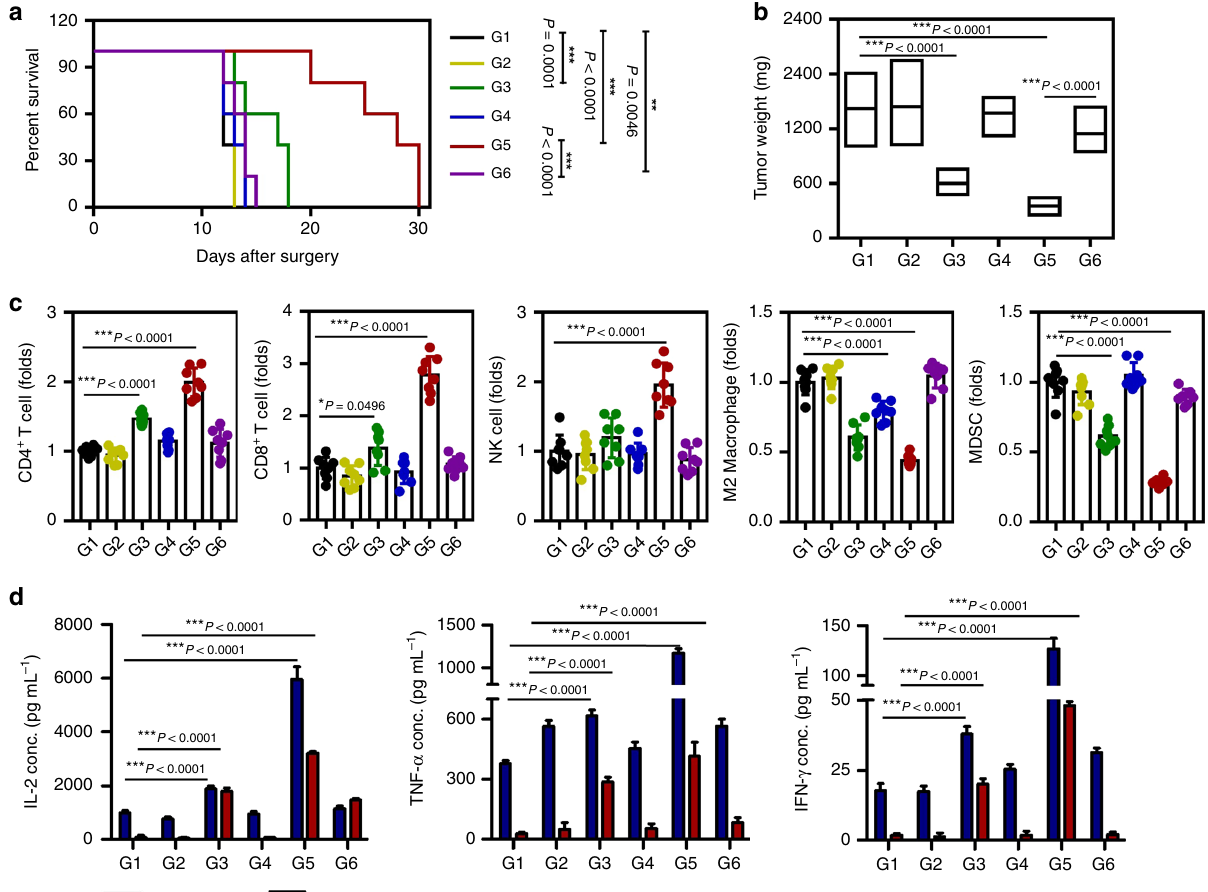
Fig. 5 Antitumor effects of syringeable iGel in post surgical TC1 tumor models. Tumors were resected when the tumor reached 300 mm 3 in size and subsequently treated as indicated in 4T1 tumor model. a Survival rate of mice after treatment. Differences in survival were determined for each group ( n = 10) by the Kaplan – Meier method, and the overall P -value was calculated by the log-rank test. b Recurrent tumor weight ( n = 10). c FACSs analysis demonstrating in fi ltrating CD4 + , CD8 + T cells, NK cells, M2 macrophages, and MDSCs in recurring tumors at day 7 post surgery ( n = 8). d Production of cytokines related to the antigen-speci fi c response in spleen and tumor-draining lymph nodes ( n = 6). Lymphocytes isolated from the spleen and tumor- draining lymph nodes were stimulated with TC1 tumor antigens for 72 h. After incubation, the supernatants were collected. IL-2, TNF- α , and IFN- γ production was measured by ELISA. Data are presented as the mean ± SD. Statistical signi fi cance was calculated by one-way ANOVA and Tukey ’ s test. Data are each pooled from two independent experiments for b – d . Source data are provided as a Source Data fi